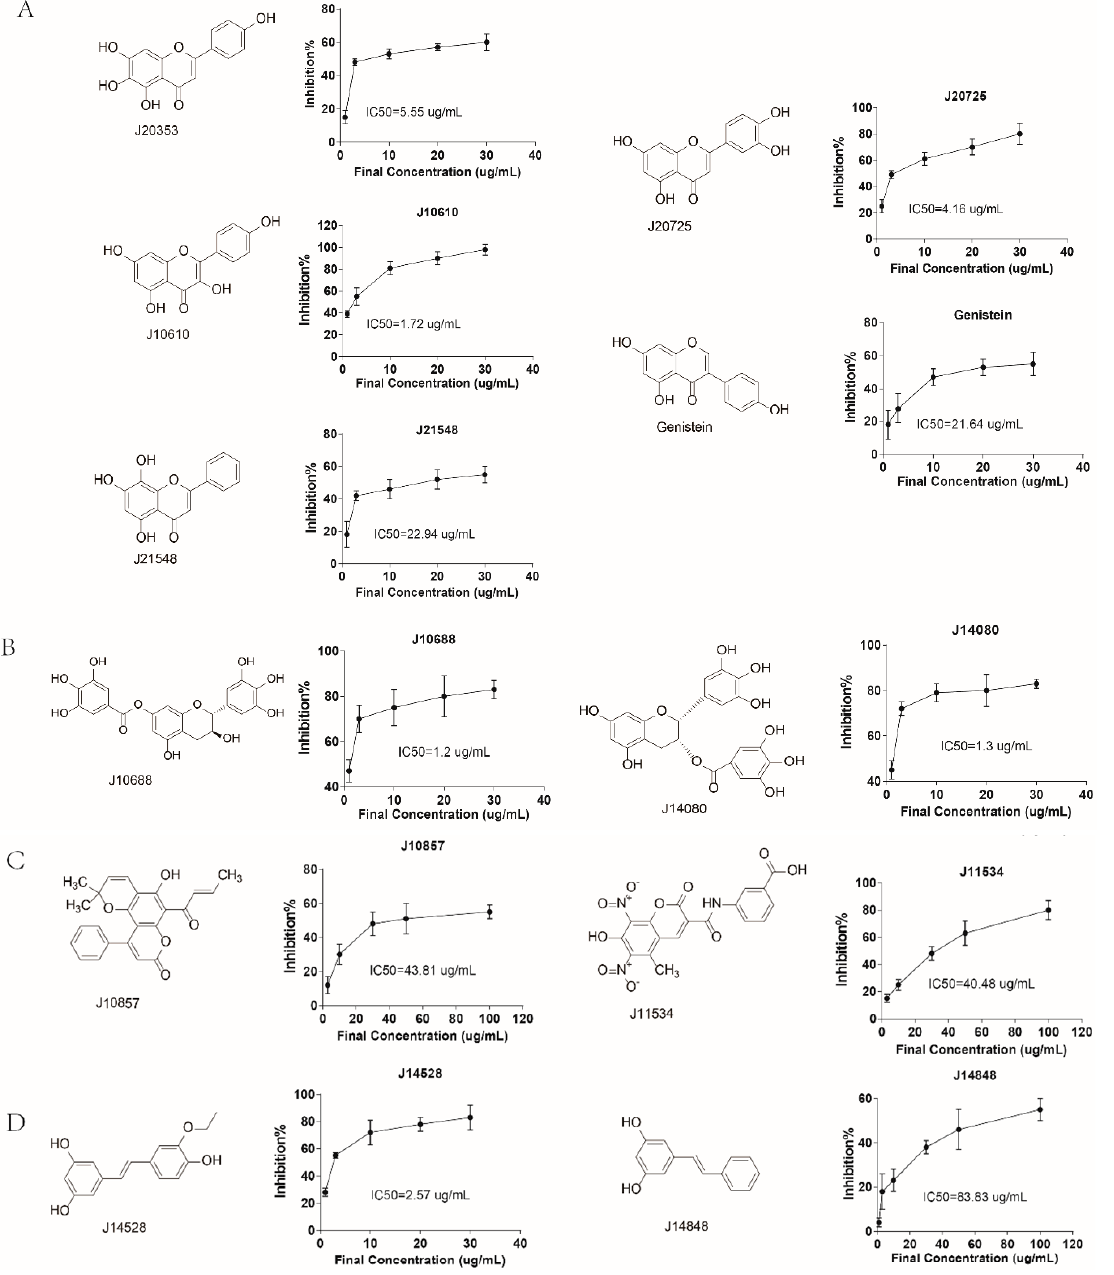
Figure 6. The structures and IC 50 s of CLK1 inhibitors after screening based on Kinase-Glo ® Assay. ( A ) flavonoids; ( B ) tannins; ( C ) coumarins; ( D ) stilbenes.